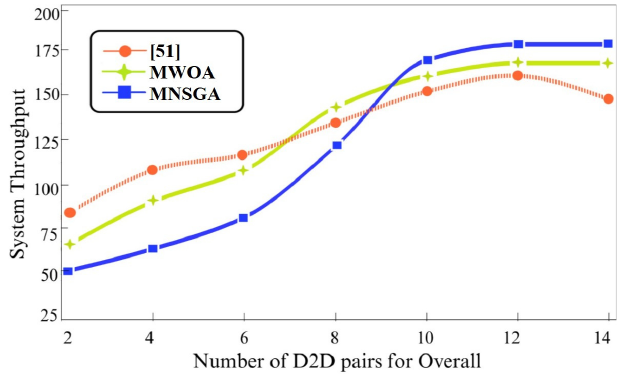
Figure 8. Overall throughputs for D2D pairs [51].